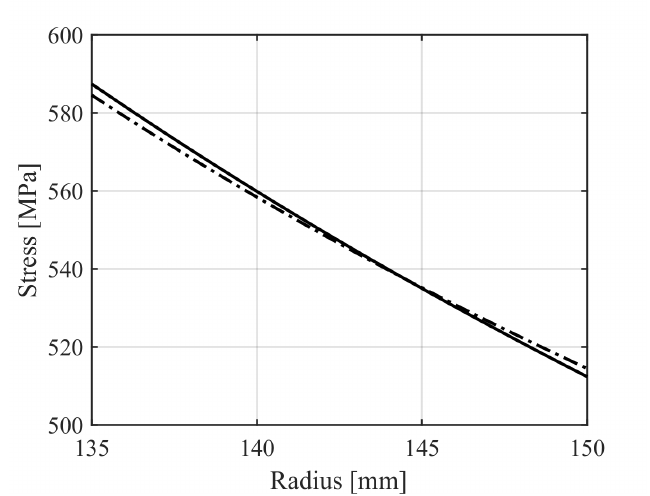
Figure 4. Von Mises equivalent stress vs radius of the flywheel: analytical plane stress (solid); numerical finite-element